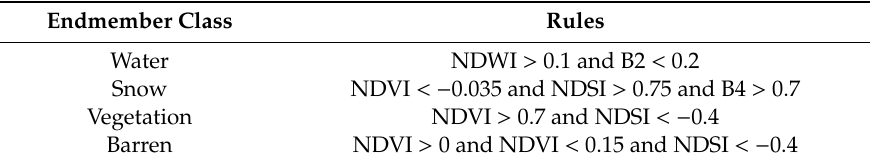
Table 3. Rules for extracting endmembers (Bi is the ith band of